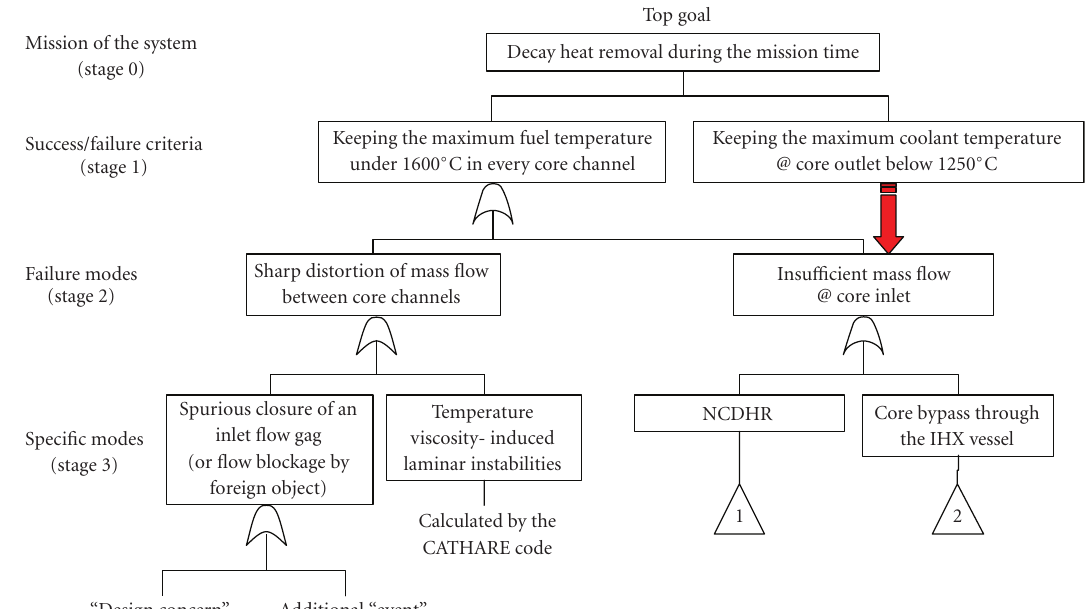
Figure 8: Deductive approach for RMPS critical parameters